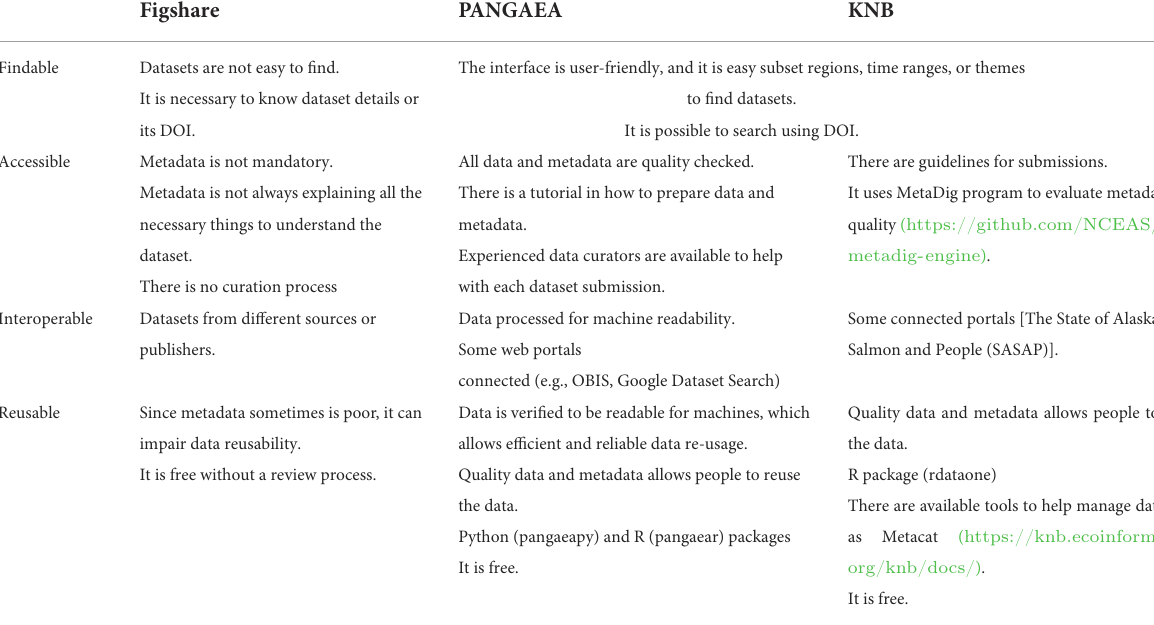
TABLE 2 FAIR principle according to repositories with marine litter data fitness for the Brazilian context. Figshare PANGAEA